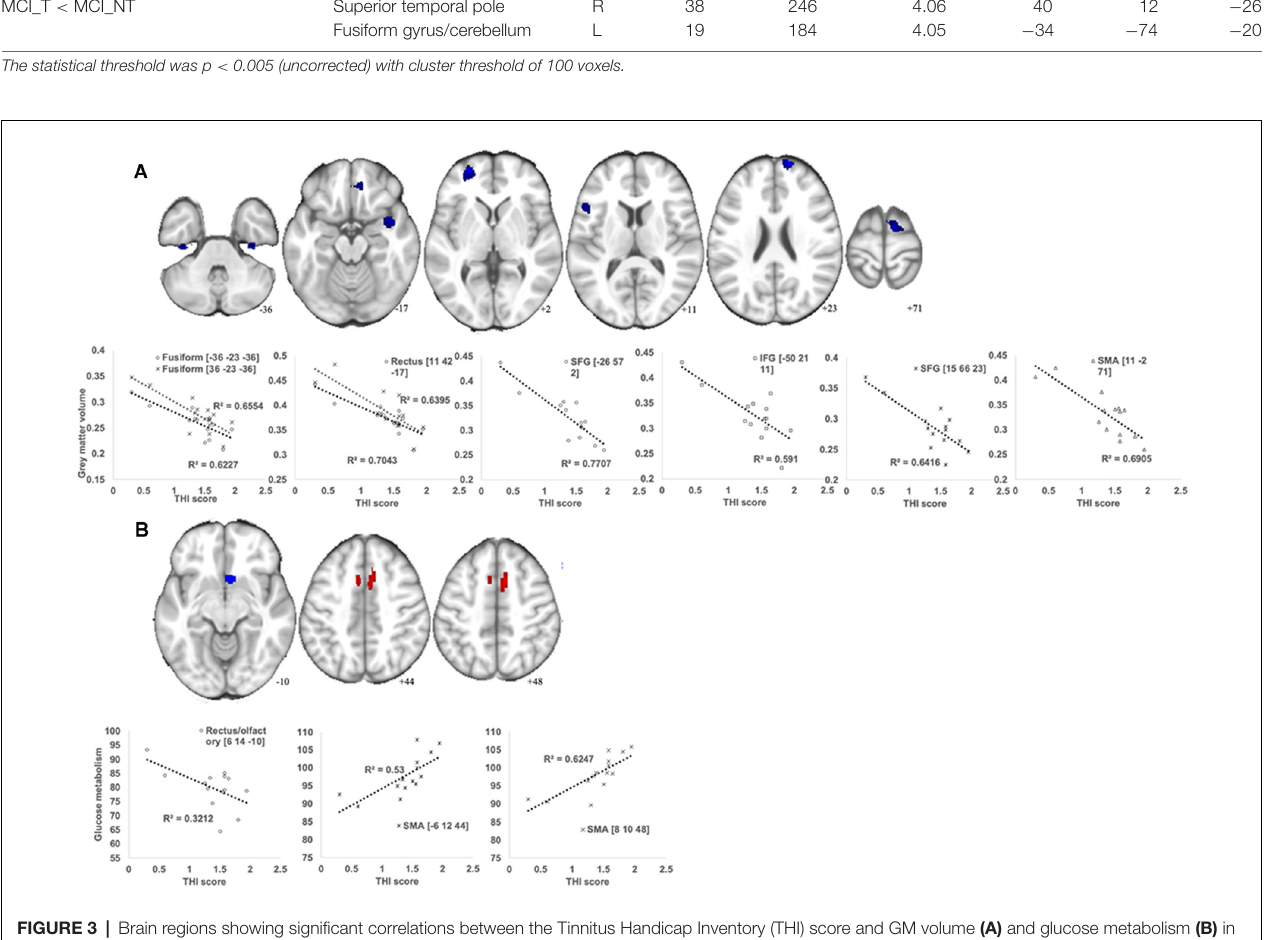
FIGURE 3 | Brain regions showing significant correlations between the Tinnitus Handicap Inventory (THI) score and GM volume (A) and glucose metabolism (B) in the MCI_T group. (A) A voxel-wise multiple regression analysis was performed to detect specific areas in which the GM volume changes are associated with the THI score in MCI_T. The plot figure shows the linear regression line in each region. All analysis was controlled by age and total intracranial volume (TIV; p < 0.005 uncorrected, k > 100). (B) A voxel-wise multiple regression analysis was performed to detect specific areas in which the glucose metabolic changes are associated with the THI score in MCI_T. The plot figure shows the linear regression line in each region. All analysis was controlled by age ( p < 0.005 uncorrected, k >